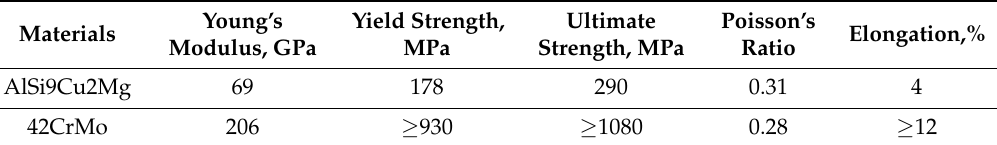
Table 3. Mechanical properties of AlSi9Cu2Mg and 42CrMo.